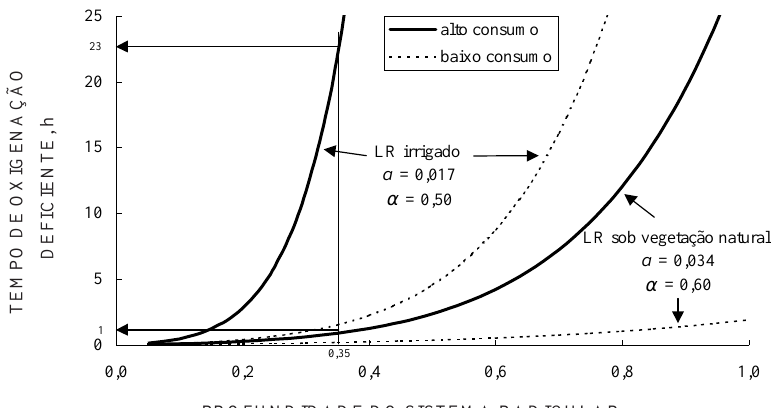
Figura 3. Tempo de oxigenação deficiente após saturação para o Latossolo Roxo descrito por Klein (1998), sob manejo com irrigação e sob vegetação natural, considerando p = 10/3 e para baixo (6,1.10 -8 kg m -3 s -1 ) e alto (28,3.10 -8 kg m -3 s -1 ) consumo de